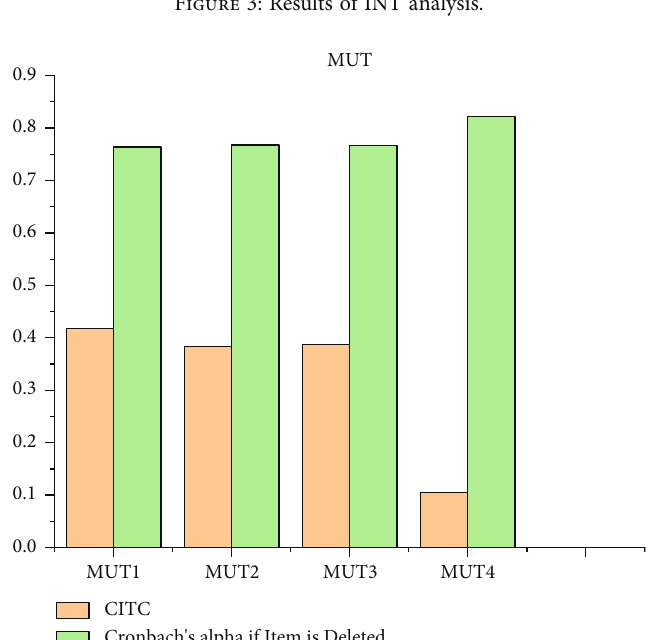
Figure 3: Results of INT analysis.